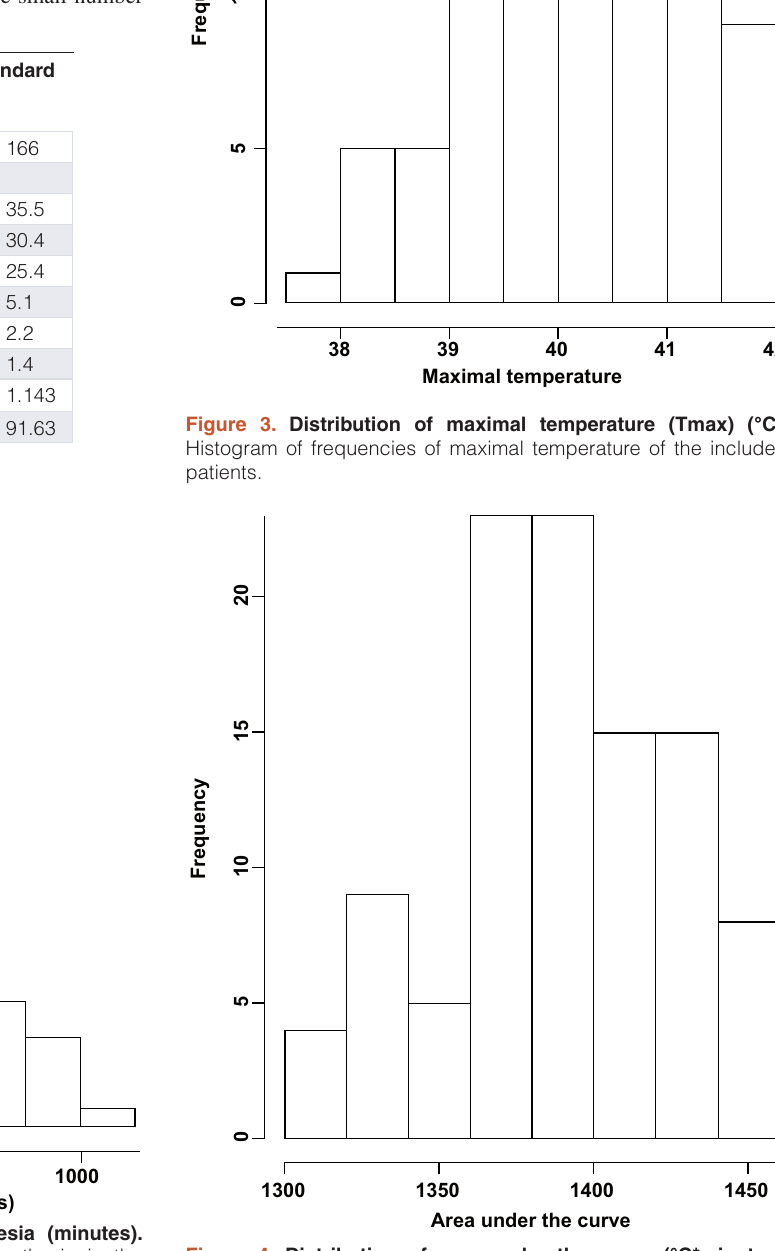
Figure 4. Distribution of area under the curve ( ° C*minutes). Histogram of frequencies of the AUC of the included patients.